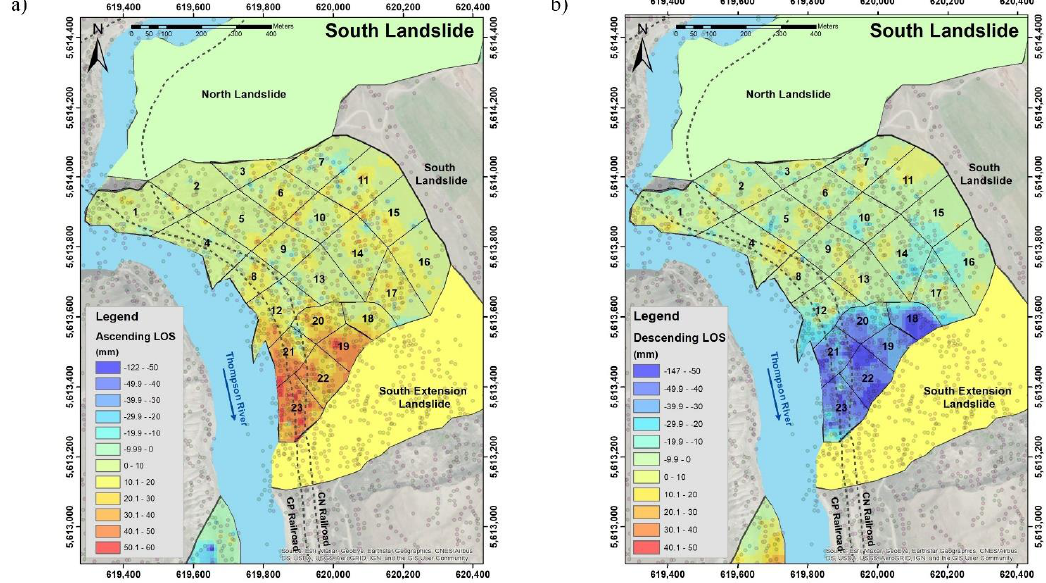
Figure 12. Cumulative 2-year LOS displacement for the South landslide. ( a ) Sentinel ascending and ( b ) Sentinel descending orbits.